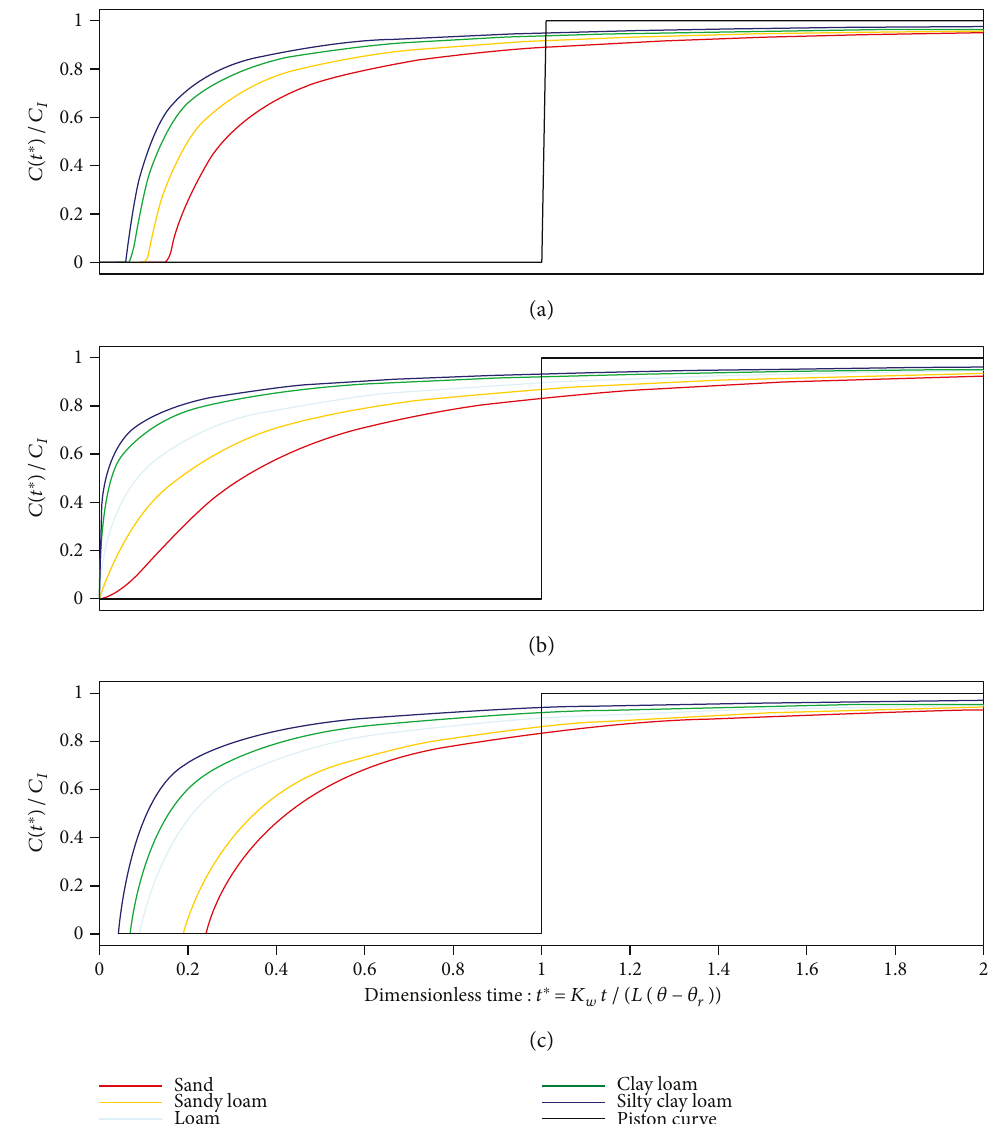
Figure 4: Breakthrough curves and the piston-shaped breakthrough curves under the unit hydraulic gradient condition for 5 typical saturated soils in (a) the Brook-Corey model, (b) the unmodi fi ed Mualem-van Genuchten model, and (c) the modi fi ed Mualem-van Genuchten